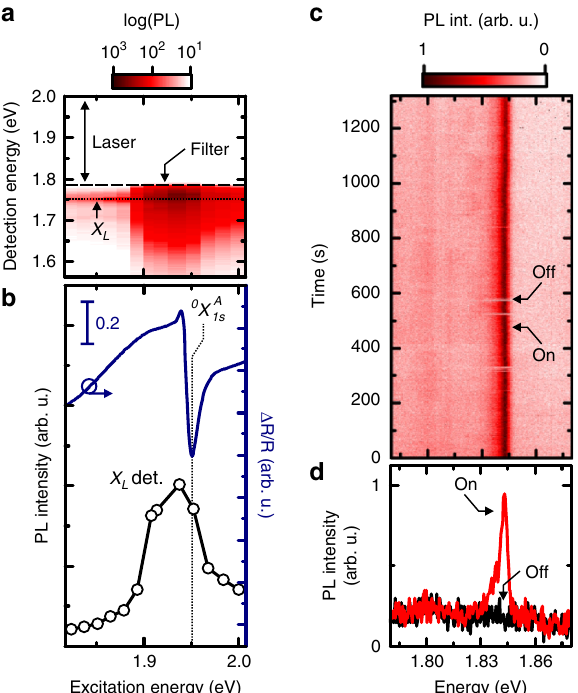
Fig. 3 PL excitation spectroscopy and time stability of optically active defect emitters. a False color plot showing the localized emission X L for the excitation being tuned across 0 X A . b The differential re fl ectivity Δ R / R of 1 s the heterostructure reveals the X A as highlighted by the dashed line. The 1 s re fl ectivity is compared to the PL intensity of the X L as a function of laser Fig. 4 Temperature-dependent PL spectroscopy of a single emission line X L excitation energy. c Time trace of the photoluminescence emission of a and independent boson model. a False color plot of the temperature- defect emitter recorded over long times. The integration time is set to 1 s dependent evolution of PL from localized and delocalized excitons. The emission energies of neutral exciton 0 X A and one defect emitter X L at 10 K 1 s are highlighted with a dashed line, respectively. b Temperature-dependent spectra of X L fi tted with an independent boson model. Best agreement is found for a B = 2 nm. c Temperature-dependent peak position of 0 X A and 1 s X L . Data are fi tted with Eq.